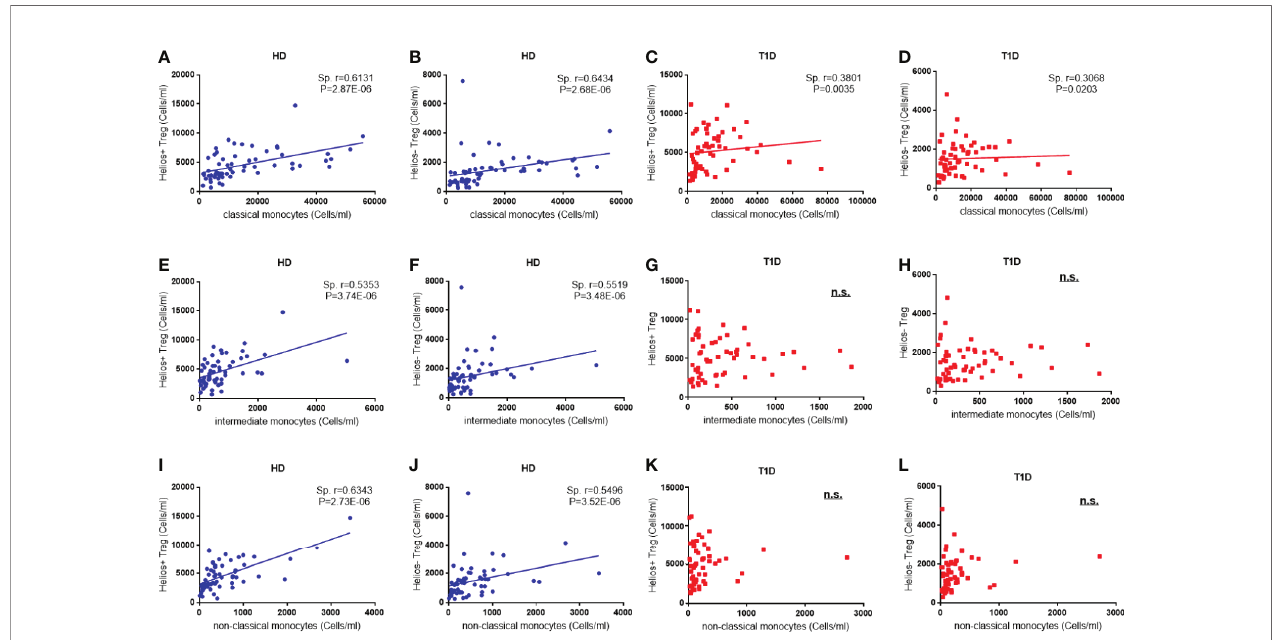
FIGURE 7 | Correlations between regulatory monocytes and Helios + and Helios − Treg subsets in T1D individuals. Correlation analysis between classical, intermediate and classical monocytes and Treg subsets from healthy donors (HD) (A, B, E, F, I, J) and T1D individuals (C, D, G, H, K, L) . Spearman rank test was used for the evaluation of the correlation. The results were from 68 autoantibody-positive T1D individuals and 68 age-matched autoantibody-negative healthy controls. Samples from T1D individuals and healthy controls were randomly divided to each independent experiment. One biological sample (from the same healthy donor and drawn at the same time) was performed as control for the experimental reproducibility. Spearman correlation was performed for these correlations. A p value <0.05 was considered as signi fi cant. ns, not signi fi